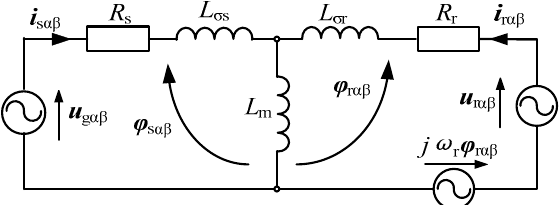
Figure 2. DFIG equivalent circuit in the stationary αβ reference frame.